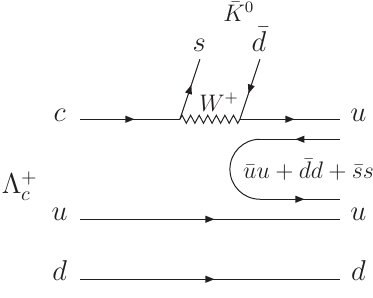
→ ¯ K 0 MB decay with c